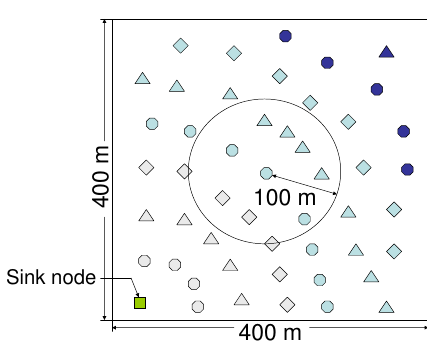
Figure 11. Network model.